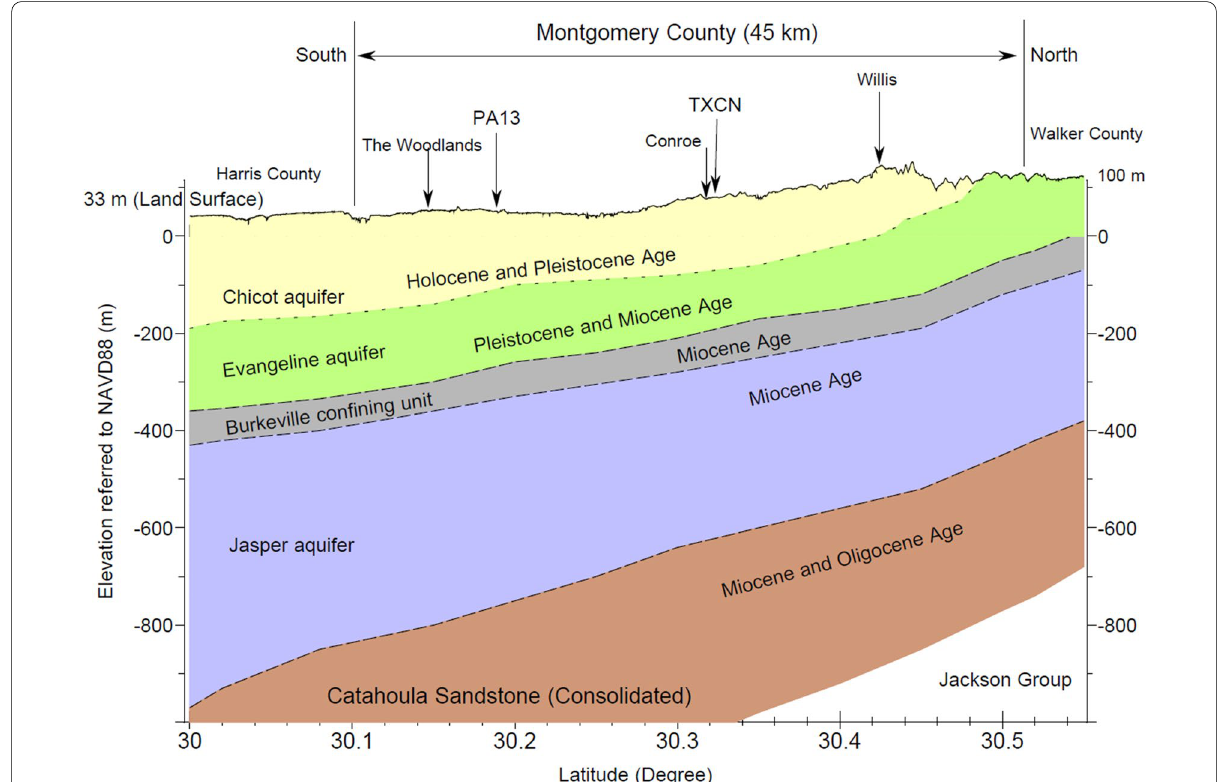
Fig. 2 Generalized hydrogeologic section of the Gulf Coast Aquifers crossing Montgomery County from the south to the north. The extension of the cross-profile is illustrated in Fig. 1 (white line). The depth and thickness information of the aquifers is combined from Popkin (1971), Baker (1979), and Young et al.